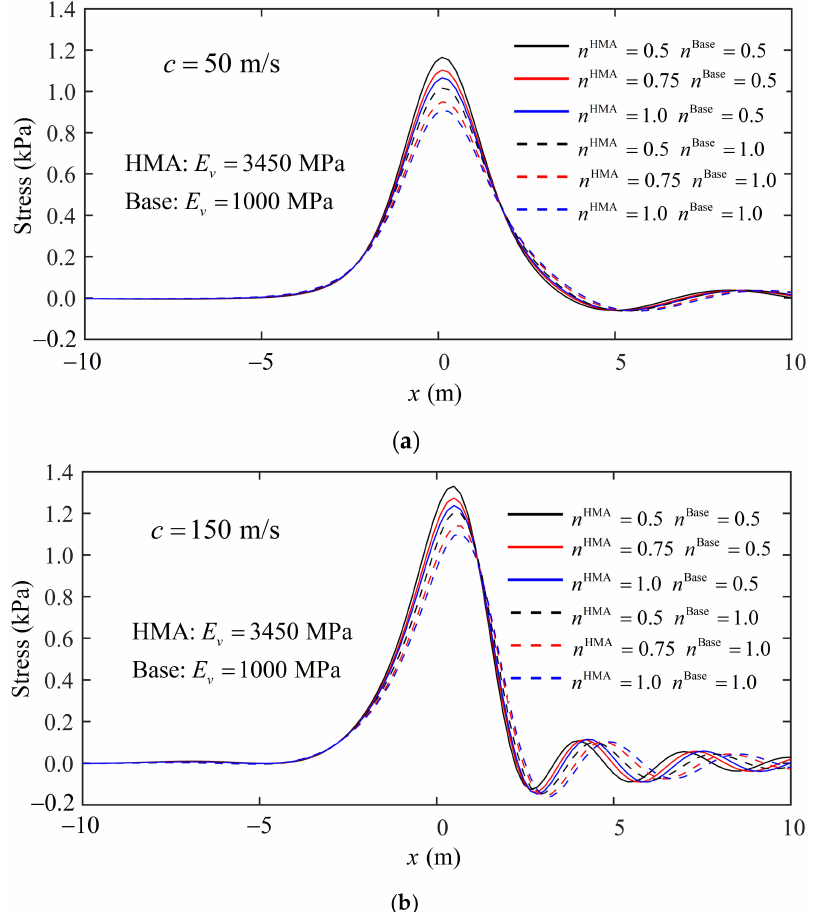
Figure 17. Effect of the layer modulus ratio, n = E h / E v , with a fixed vertical modulus on the vertical stress fluctuation amplitude at the lower bound of the base layer, induced by a moving Gaussian load, with speeds of ( a ) c = 50 m/s and ( b ) c = 150